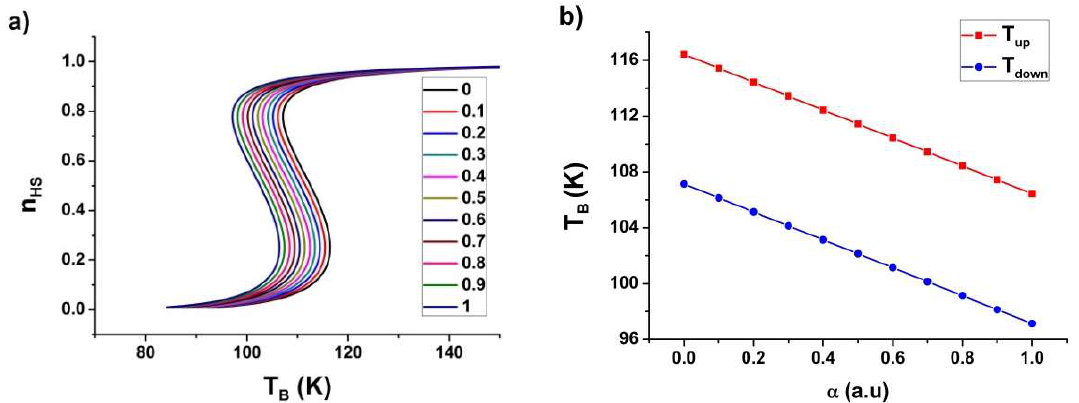
Figure 9. ( a ) Simulated bath-temperature (T B ) dependence of the HS fraction under various light intensities (from 0 to 1, given in arbitrary units) for, ∆ C p = 0, showing a monotonous linear shift of the hysteresis loop. ( b ) Light intensity dependence of the upper and the lower transition temperatures of the thermal hysteresis leading to parallel lines. Used parameter values are: J = 155 K, ∆ = 394 K, g = 1097, C LS p = 0.1 a.u., and C HS p = 0.1 a.u.